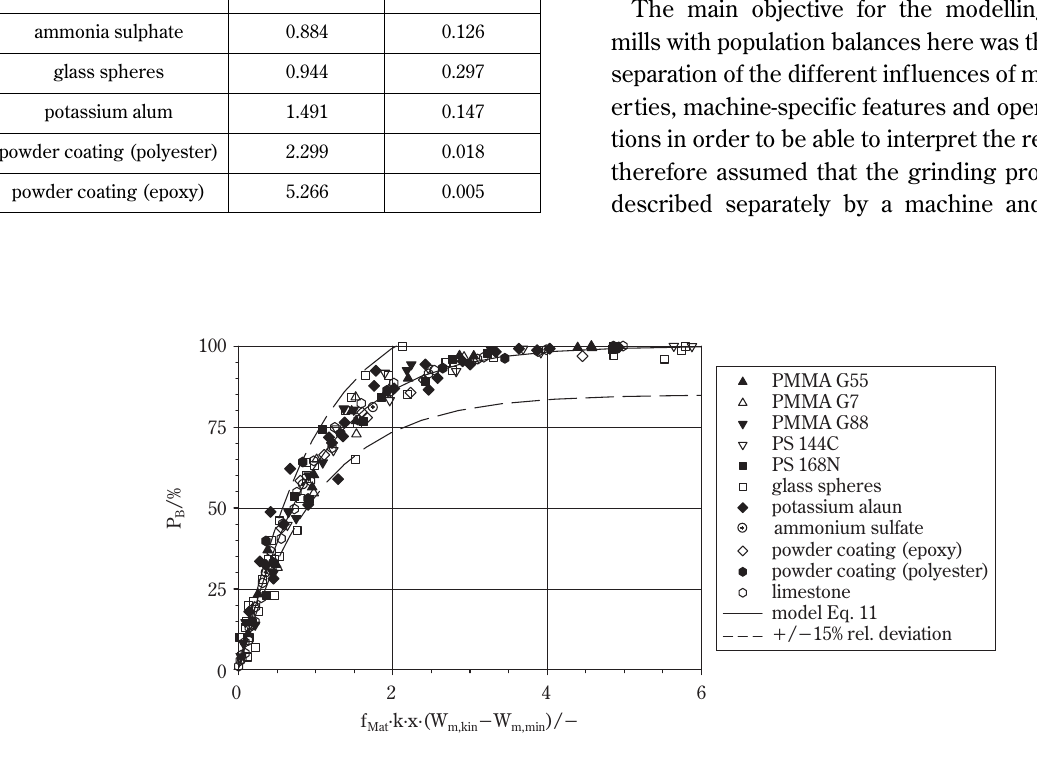
Fig. 5 Mastercurve for the breakage probability of various materials